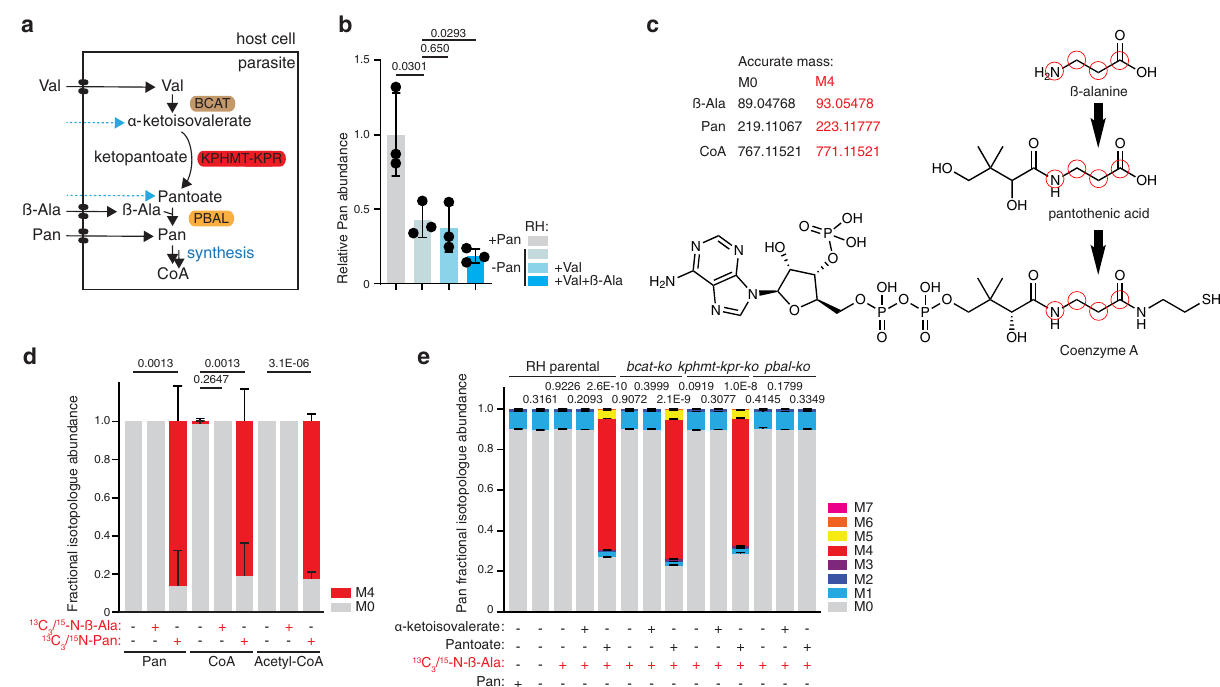
Fig. 6 T. gondii tachyzoites salvage Pan synthesis intermediates and use these for Pan synthesis. a Scheme of the Pan biosynthesis pathway, highlighting the ketopantoate hydroxymethyltransferase - ketopantoate reductase (KPHMT-KPR) and the pantoate beta alanine ligase (PBAL). Salvage of α -ketoisovalerate and pantoate as precursors for Pan synthesis is shown. See Fig. 1 for abbreviations. b GC-MS Measurement of relative intracellular Pan levels in RH parental parasites following incubation in medium without Pan supplemented with valine (Val, 3 mM) and β -alanine ( β -Ala, 2 mM) ( n = 3, mean and SD, 2-sided Student ’ s t test). c Metabolite structures highlighting the theoretical incorporation of labeled atoms (red circles) from stable isotope labeled 13 C 3 / 15 N- β -Ala into Pan and into CoA. Exact masses of the parental ion (M0), and heavy stable isotope labeled (M4) are presented in black and red, respectively. d LC-MS analysis of the relative isotopologue (M0, M4) abundance of RH parental derived metabolites following incubation in medium with 3 mM 13 C 3 / 15 N- β -Ala or 100 μ M 13 C 3 / 15 N-Pan ( n = 4, mean and SD, 2-sided Student ’ s t test). e LC-MS analysis of Pan isotopologue (M0 to M7) distribution of RH parental, bcat-ko , kphmt-kpr-ko , pbal-ko derived metabolites following growth over 40 h in regular DMEM, DMEM − Pan + 5 % dialyzed FBS supplemented with metabolites as indicated: α -ketoisovalerate, pantoate, 13 C 3 / 15 N- β -Ala (each at 0.8 mM). Statistical analysis was carried out on the percentage of labeling shown in supplementary data ( n = 3, mean and SD, 2-sided Student ’ s t test). n number of independent biological replicates. Source data are provided as a Source Data fi